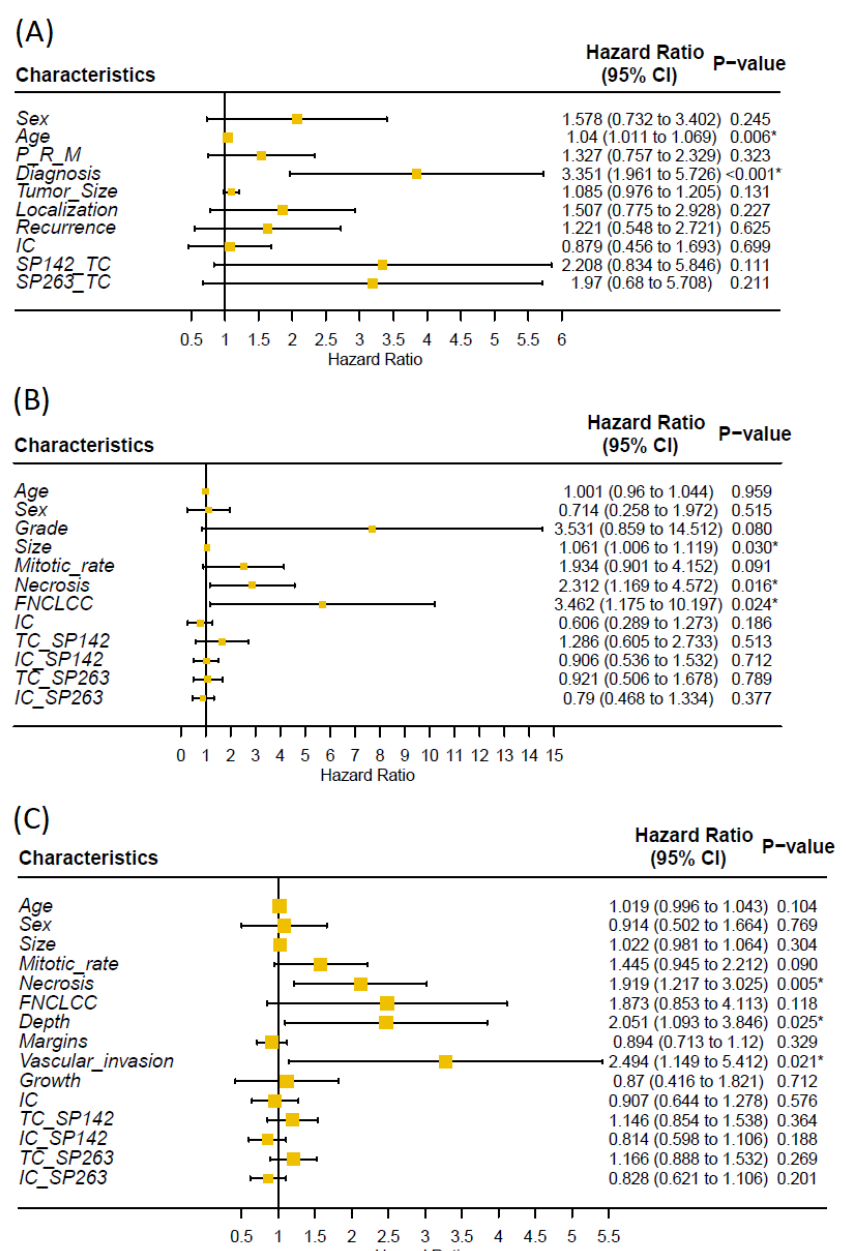
Figure 2. Univariate cox regression analysis of association between clinical/tumor characteristics, PD-L1 immunoreactivity and overall survival of ( A ) chondrosarcoma, ( B ) liposarcoma and ( C ) un- differentiated pleomorphic sarcoma (P = primary, M = metastasis, R = recurrence, * = p < 0.05). We found no significant association between PD-L1 immunoreactivity and overall